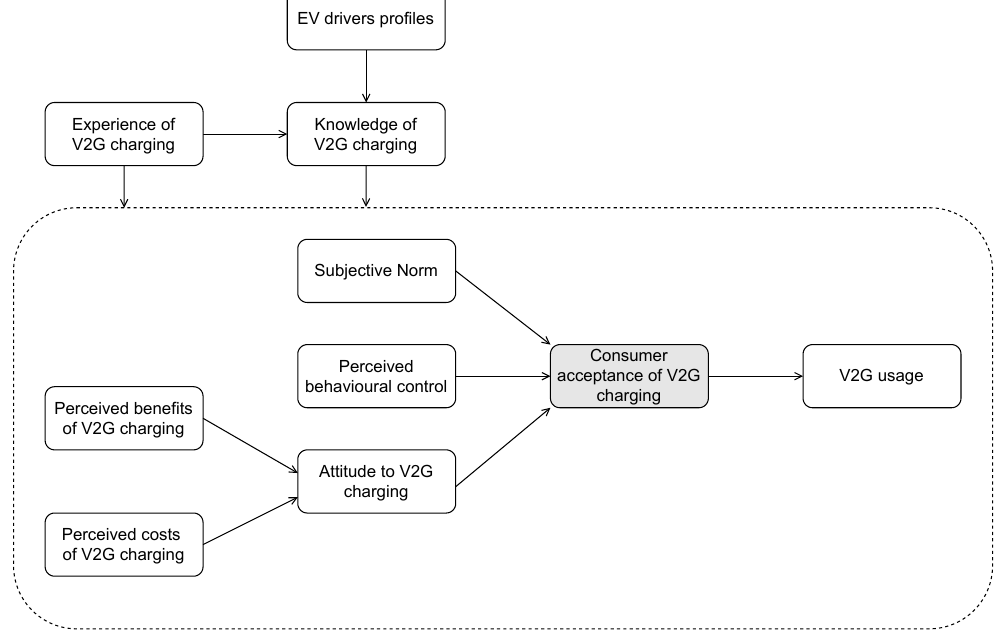
Figure 1. Conceptual model describing the influence of factors on consumer acceptance of V2G (modified based on Huijts et al.